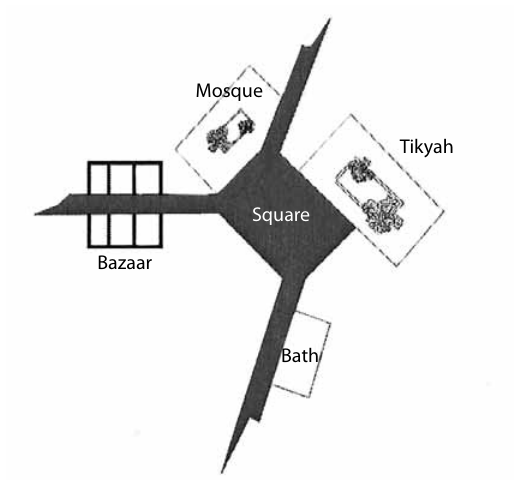
fig. 5. Sketch of a neighbourhood centre (Khaghani 2012)